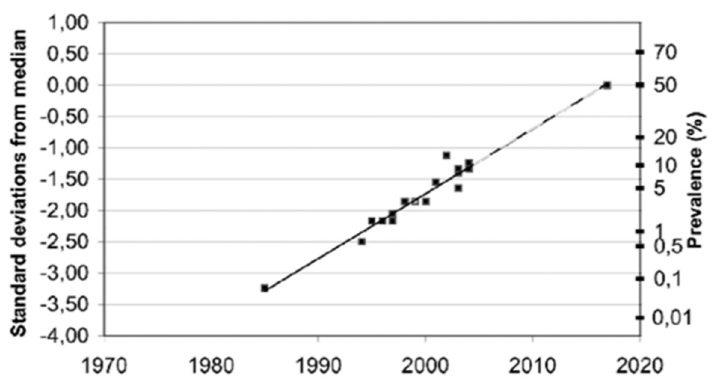
Figure 7. Estimated prevalence (%) of people around the world who consider themselves to be electrohypersensitive, plotted over time in a normal distribution graph, according to Reference [73].